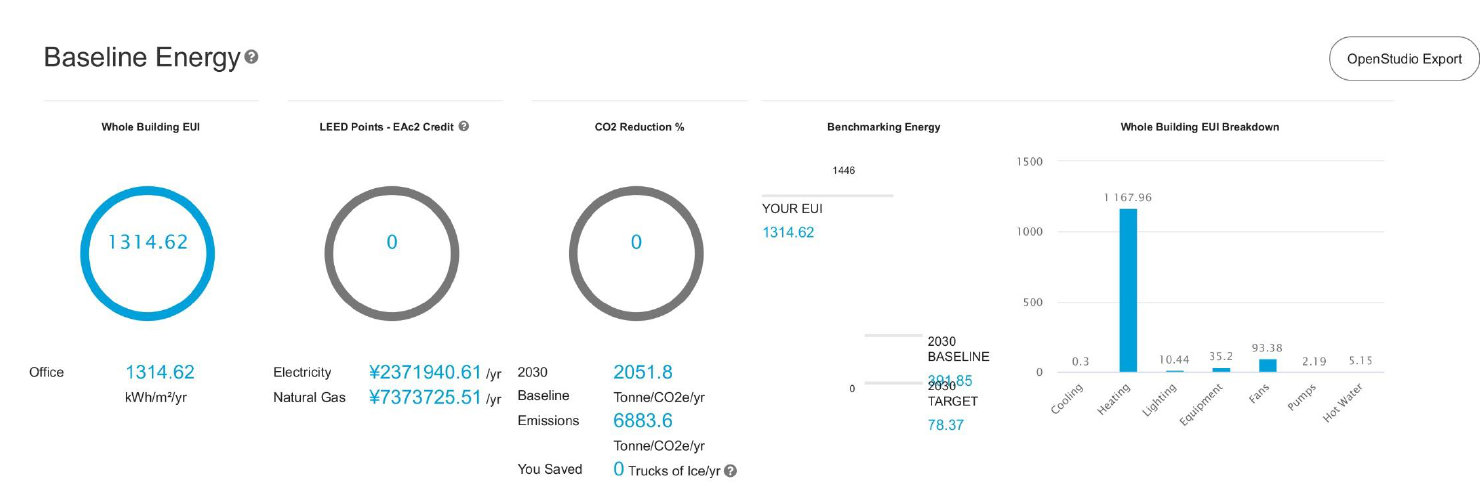
Figure A47. Zone 8 Tahé, Heilongjiang (post-COVID-19 78% scenario).